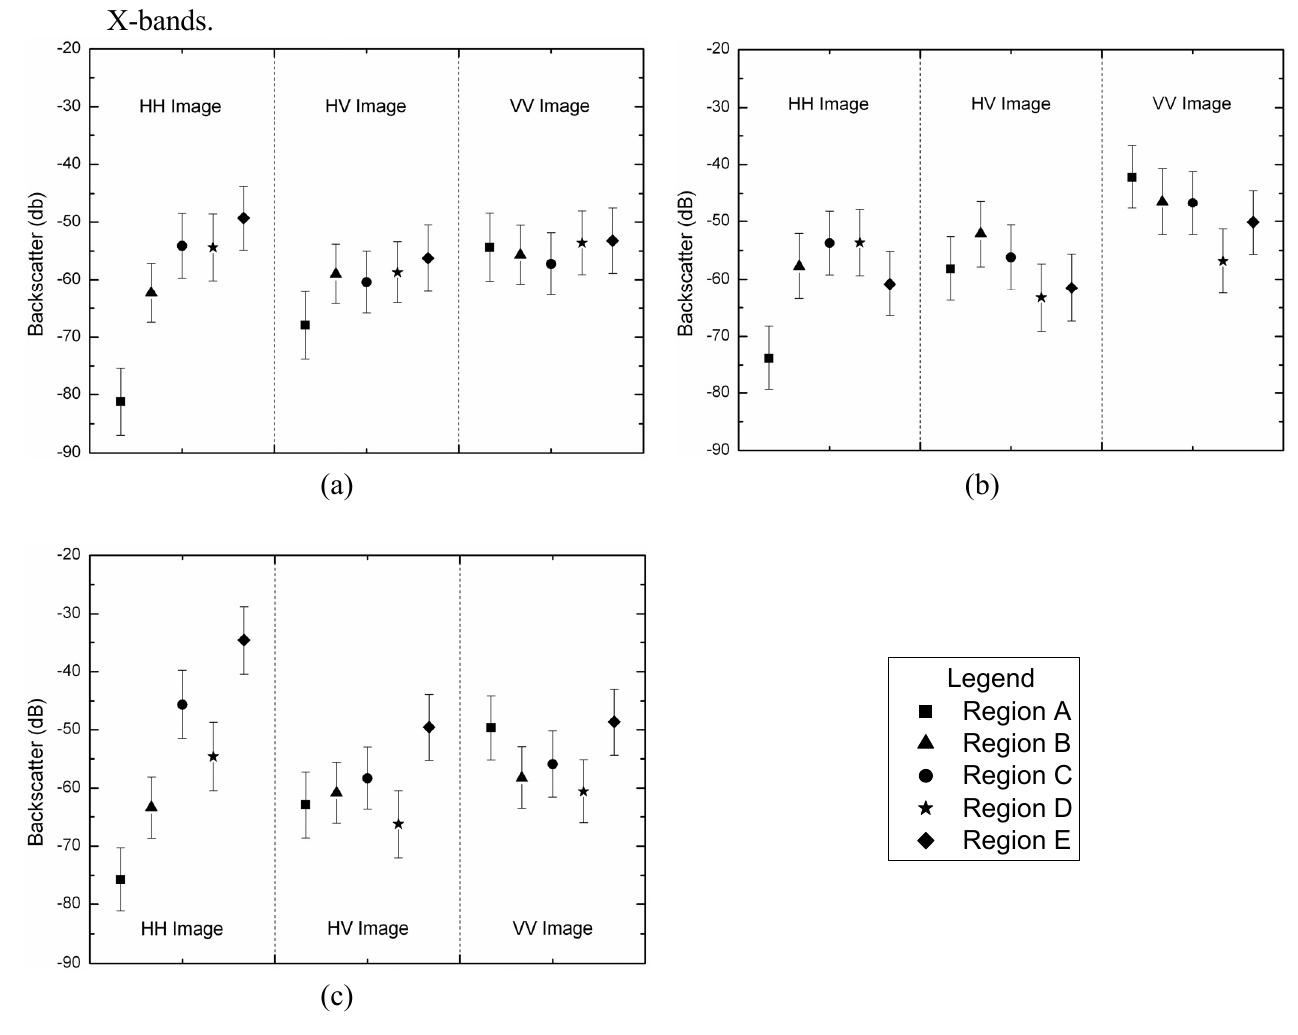
Figure 11. Mean backscatter values for each image region, per channel: (a) L-, (b) C- and (c)